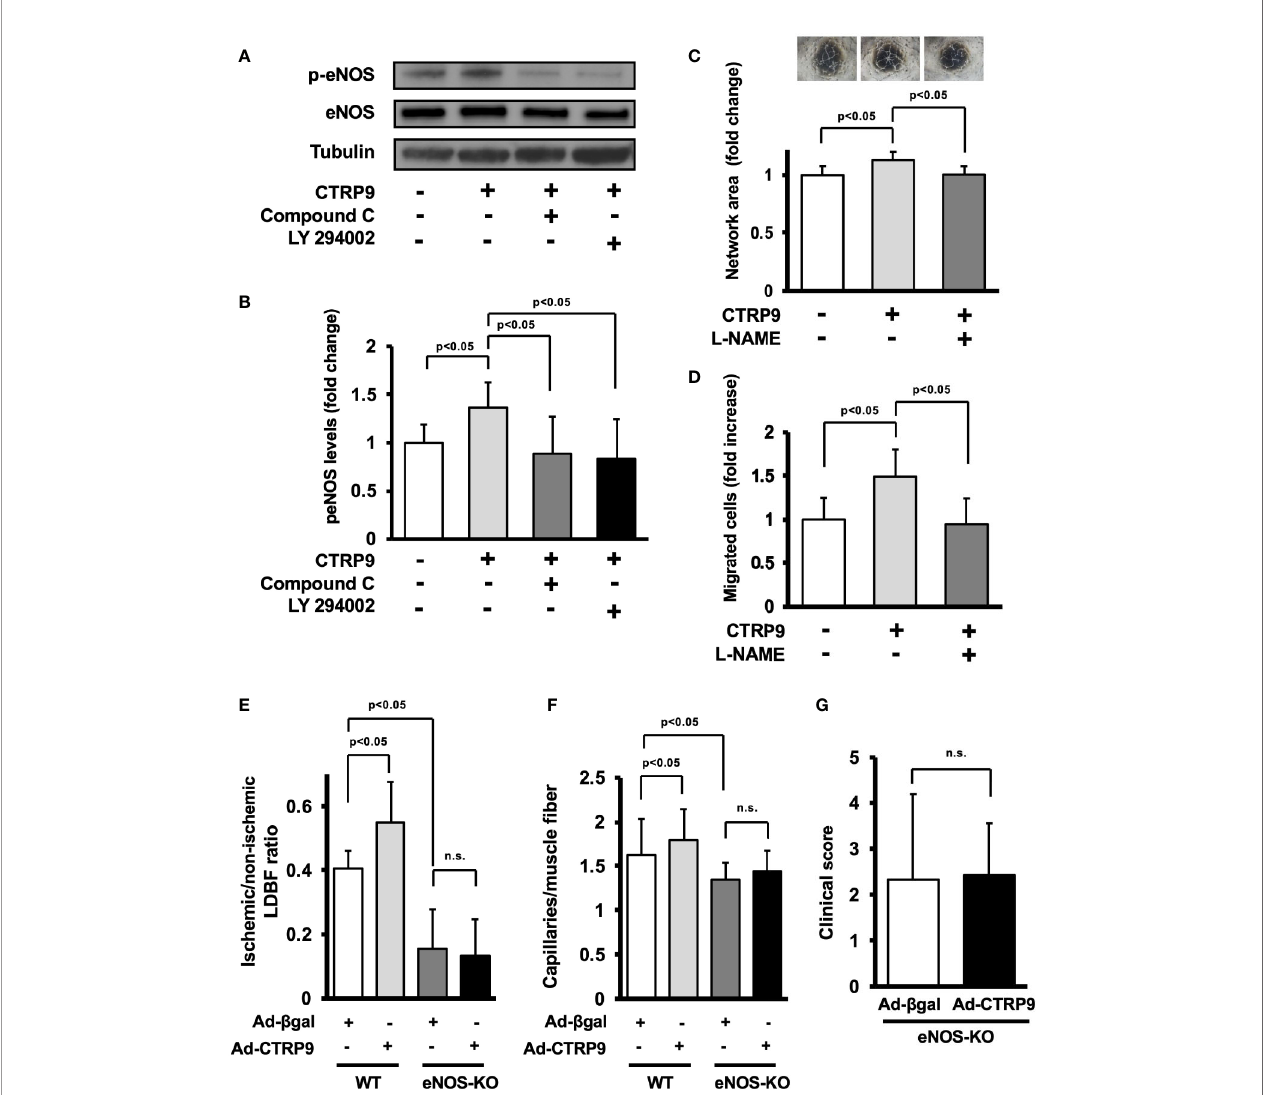
FIGURE 5 | Endothelial nitric oxide synthase (eNOS) signaling is required for angiogenic response to CTRP9. (A) Effect of Compound C and LY294002 on CTRP9- stimulated eNOS phosphorylation. Human umbilical vein endothelial cells (HUVECs) were pretreated with Compound C (10 µmol/L), LY294002 (10 µmol/L), or vehicle (DMSO) for 30 – 60 min and treated with CTRP9 (10 m g/ml) or PBS (control) for 15 min. Phosphorylated eNOS (p-eNOS) was determined by Western blot analysis. (B) Quantitative analysis of relative changes in p-eNOS is shown. Relative phosphorylation levels of eNOS were quanti fi ed by using ImageJ software. Relative phosphorylation levels were normalized to total protein signal. Results are presented as mean ± SD (n = 5 independent culture experiments). (C) Contribution of eNOS to CTRP9-induced network formation of HUVECs. HUVECs were pretreated with L-NAME (1 mmol/L) or vehicle (PBS) and treated with CTRP9 (10 m g/ml), or PBS (control) for 17 h. Representative photomicrographs of HUVEC network formation are shown (upper panel). Quantitative analyses of the network area of tubes are shown. Results are presented as mean ± SD (lower panel) (n = 5 – 9 independent culture experiments). (D) Contribution of eNOS to CTRP9-induced migration of HUVECs. A modi fi ed Boyden chamber assay was performed using HUVECs. HUVECs were pretreated with L-NAME (1 mmol/L) or vehicle (PBS) and treated with CTRP9 (10 m g/ml), or PBS (control). Results are presented as mean ± SD (n = 4-5 independent assays). (E) Quantitative analysis of ischemic to nonischemic laser Doppler blood fl ow (LDBF) ratio in Ad-CTRP9 or Ad- b -gal-treated WT and eNOS-KO mice on postoperative day 14 (n = 5 – 7 mice for each group). (F) Quantitative analysis of capillary density in Ad-CTRP9 or Ad- b -gal-treated WT and eNOS-KO mice on postoperative day 14. Capillary density was expressed as the number of capillaries per muscle fi ber. Results are presented as mean ± SD (n = 3 mice for each group). (G) Clinical score in eNOS-KO mice receiving Ad-CTRP9 or Ad- b -gal as determined by an index of severity of limb ischemia (n = 6-7 mice for each group). ns, not signi fi